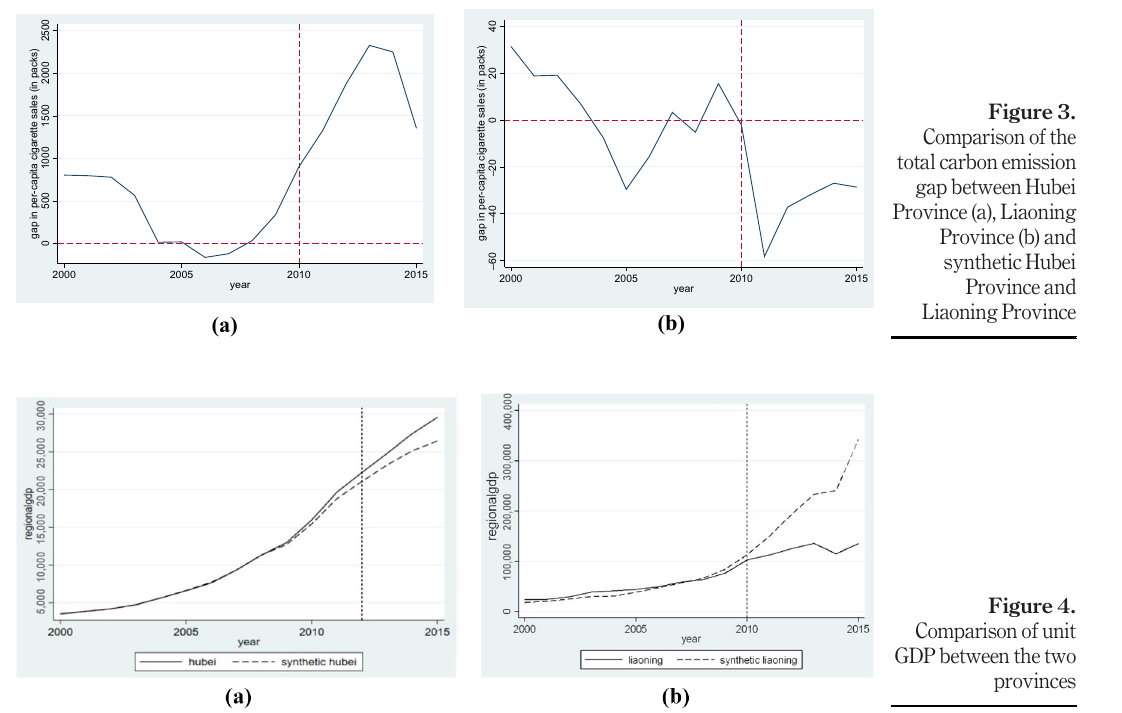
Figure 4. Comparison of unit GDP between the two